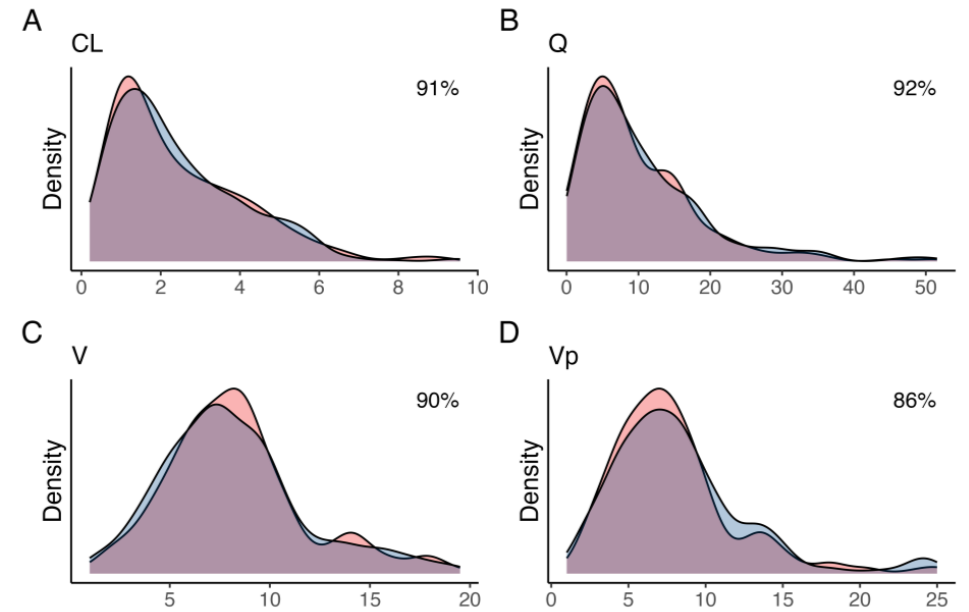
Figure 1. Kernel density estimates for the posterior (blue) and simulated (red) for ( A ) clearance from the central compartment (CL), ( B ) inter-compartmental clearance (Q), ( C ) central volume (V), and ( D ) peripheral volume (Vp). The overlap coefficient for empirical distributions between the posterior and simulated parameter distribution is shown in the top-right corner. Table 1. Weighted mean and weighted median (95% credibility interval) of the population pharma- cokinetic model parameters support points for the original and simulated dataset.